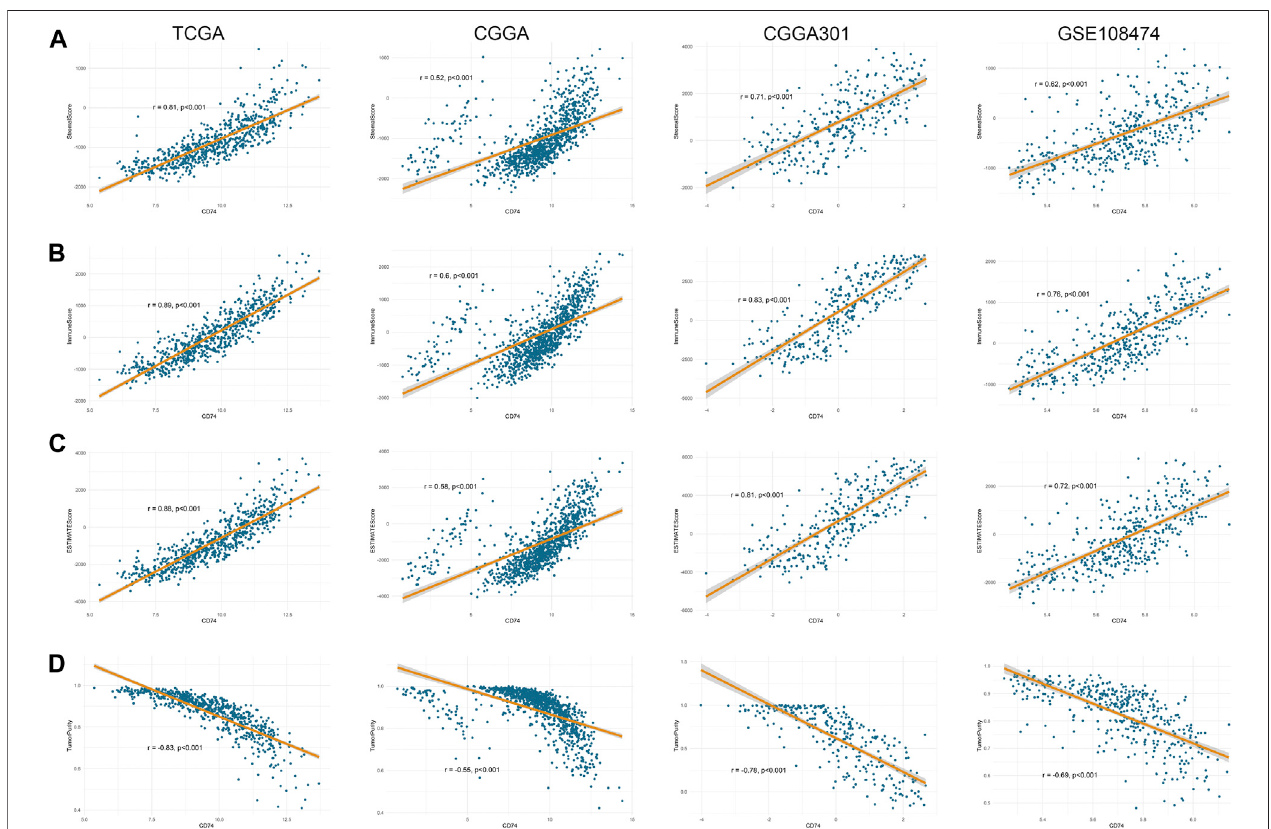
FIGURE 6 | Correlation between CD74 expression and tumor purity. A-D. Tumor purity was assessed by ESTIMATE algorithm. The correlation between CD74 expression and stromal score (A) , immune score (B) , ESTIMATE score (C) , and tumor purity (D) in the four